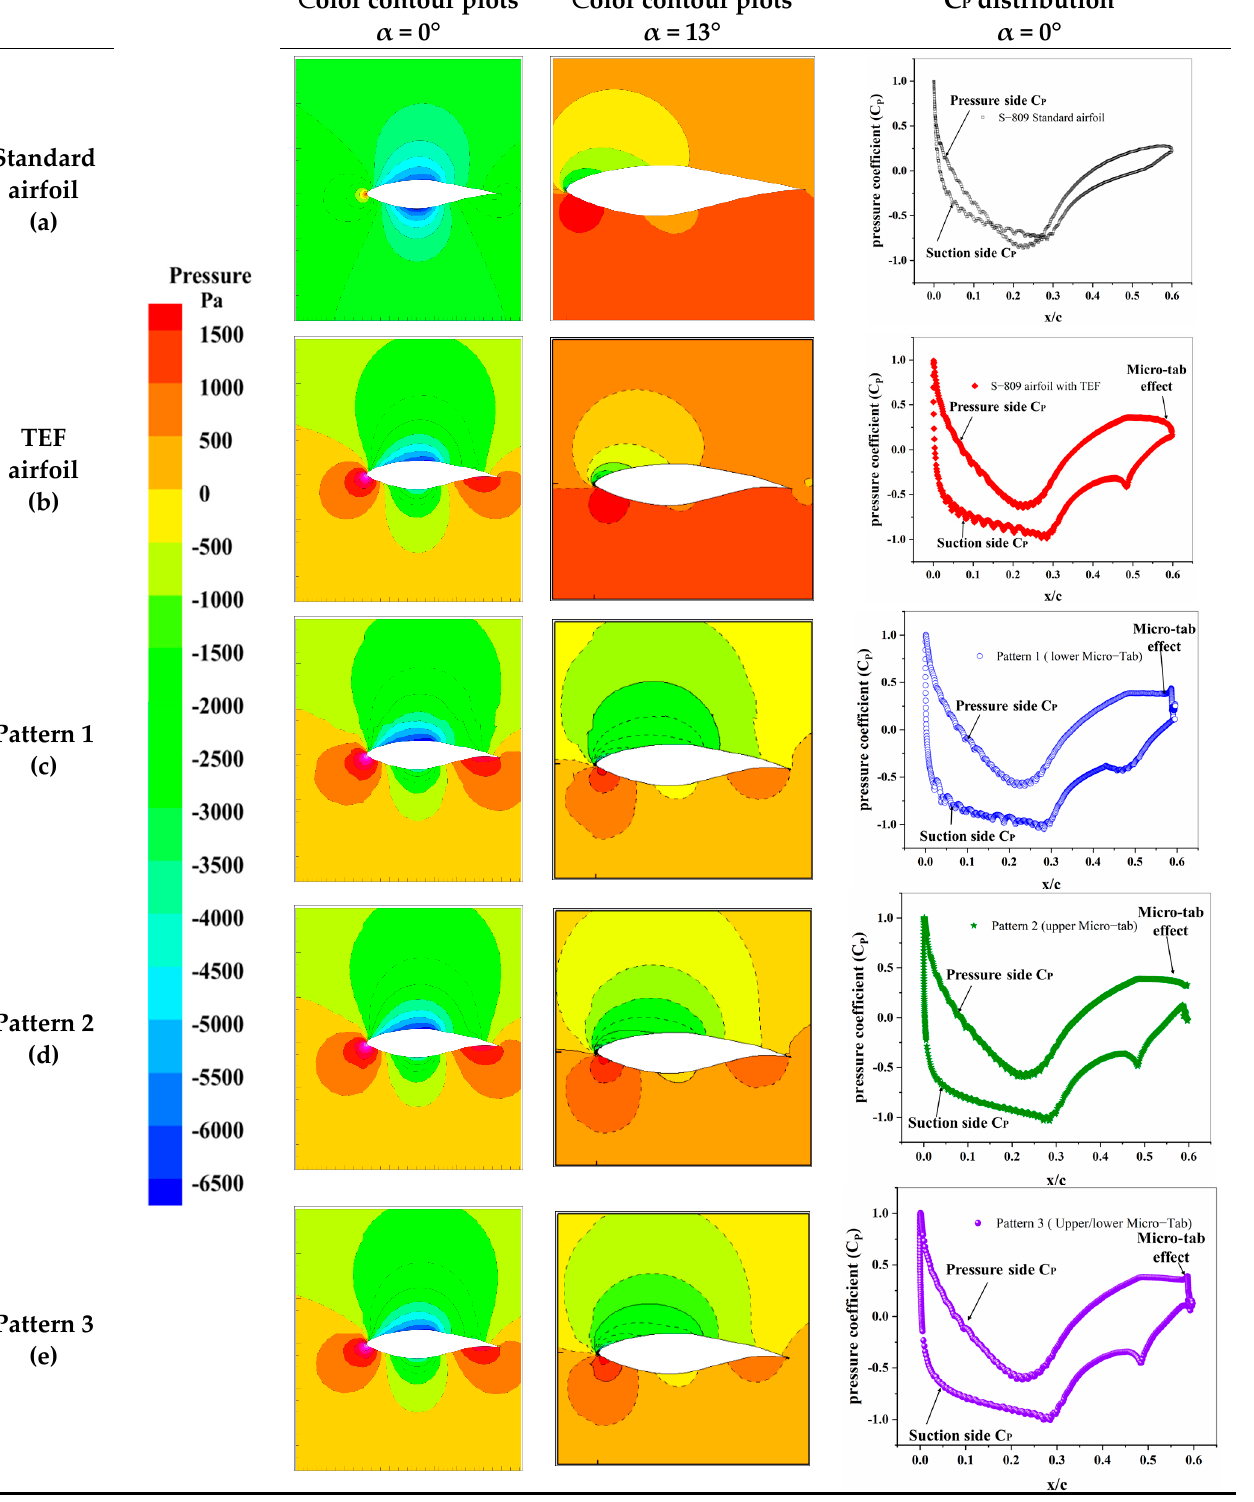
Figure 8. Pressure distribution and color contour plots at the α =0°–13°, ( a ) S − 809 airfoil, ( b ) TEF airfoil, ( c ) Pattern 1, ( d ) Pattern 2, ( e ) Pattern 3. Two C P distributions are presented for two different α , which represent low and high α , respectively. Unsurprisingly, for both angles, Pattern 1 increases the pressure on